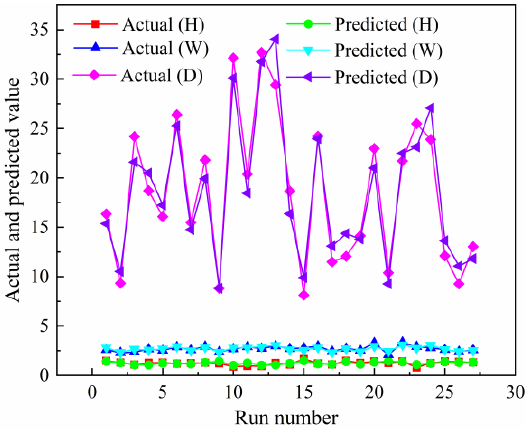
Figure 5. Comparative chart for the actual and predicted